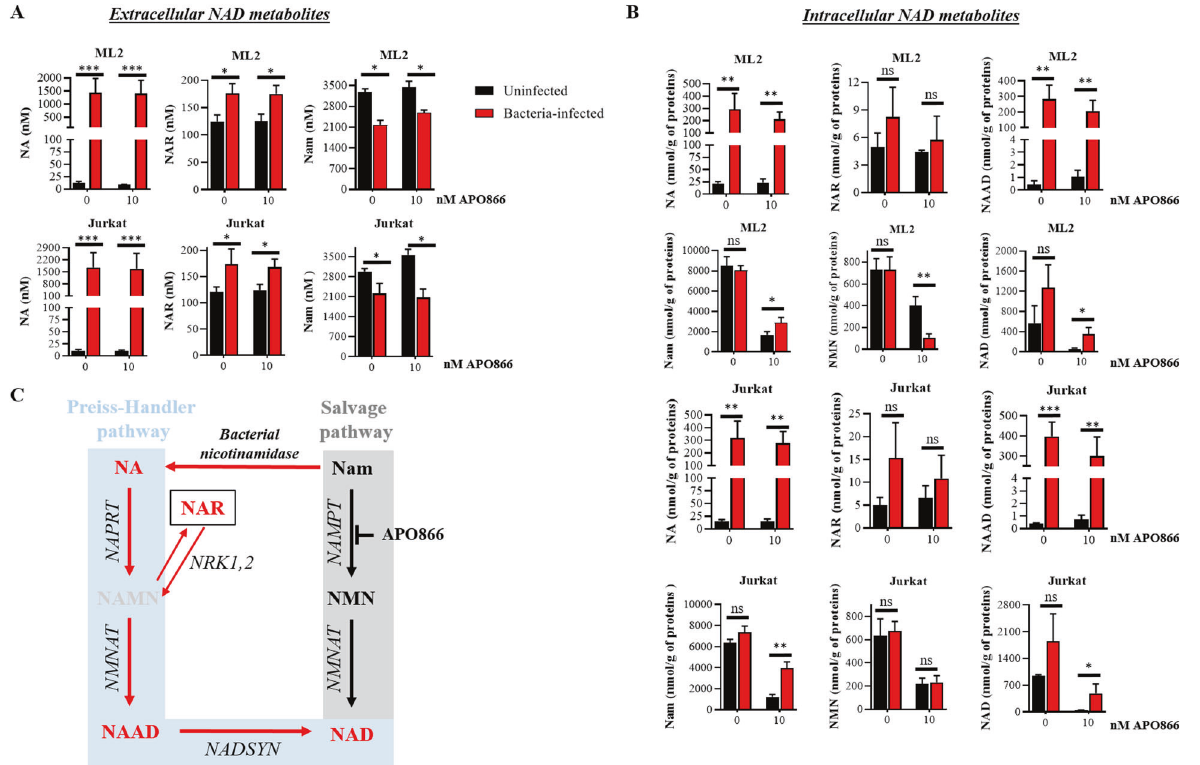
Fig. 3 Bacteria circumvent APO866-induced anti-leukemic activities by activating the Preiss-Handler pathway to synthesize NAD + . Quanti fi cation of extracellular ( A ) or intracellular ( B ) NAD + metabolites in cell-conditioned medium (or supernatant) or within cells from uninfected- or bacteria-infected ML-2 and Jurkat cells, using LC-MS/MS. C Summary of identi fi ed NAD + metabolites: in red, metabolites signi fi cantly increased; black, no changes; and grey, metabolites, not detected (below the limit of detection). Data are derived from at least three independent experiments. Data are mean ± SD; * p < 0.05, ** p < 0.01, *** p < 0.001, ns Not signi fi